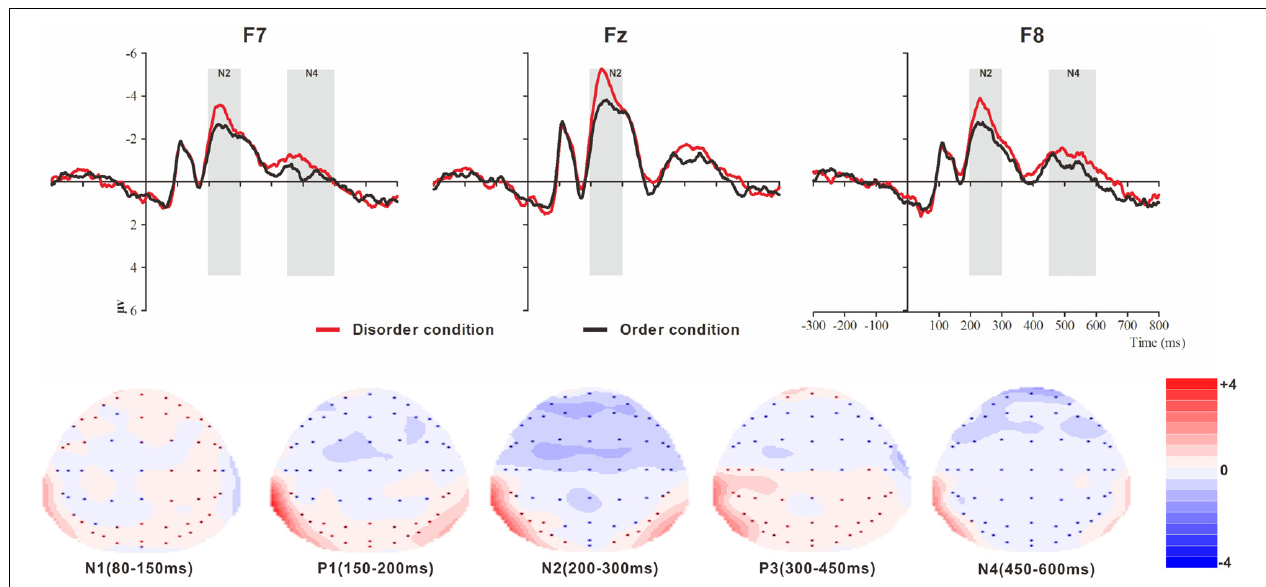
FIGURE 4 | Top: Average ERP waveforms at frontal F7, Fz, and F8 electrodes elicited by centrally presented physical environment disorder (red line) or order (black line) pictures. The significant differences between the disorder and order conditions are indicated by the gray (negative differences) rectangles, respectively. Time = 0 ms indicates the stimulus onset. Bottom: Topographic maps of the mean voltage amplitudes for the difference waveforms (disorder condition minus order condition) matched to the time window of each component elicited by the stimuli (notably the frontal locations). Increased negativity is shown in blue, and increased positivity is shown in red.